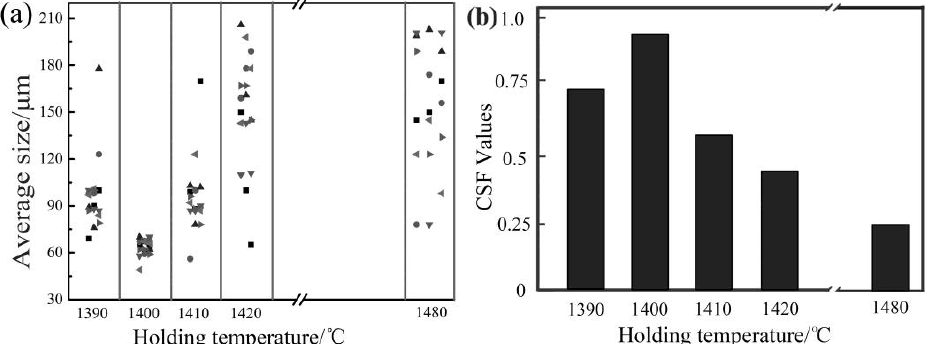
Figure 2. Analysis of solidification microstructure by various isothermal treatment temperatures of Ni-Cr-W superalloy: ( a ) the average particle size; ( b ) the shape factor of circle.